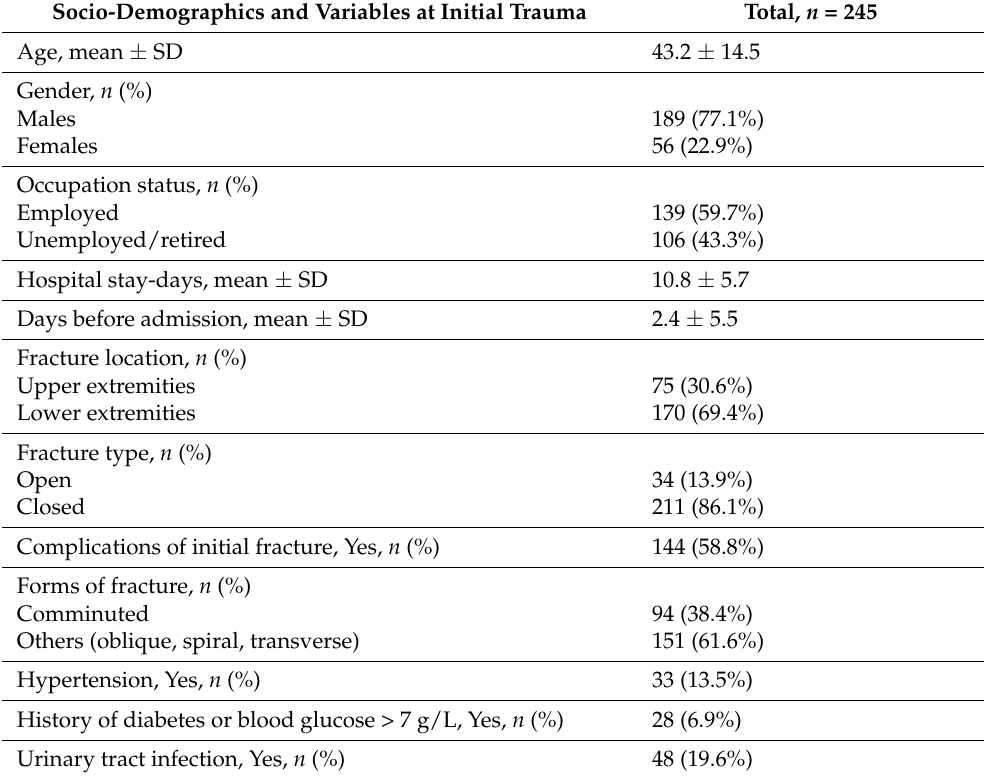
Table 1. Descriptive analysis of socio-demographics and variables related to initial trauma. Ceph, cephalosporins; BMI, body mass index; SD, standard